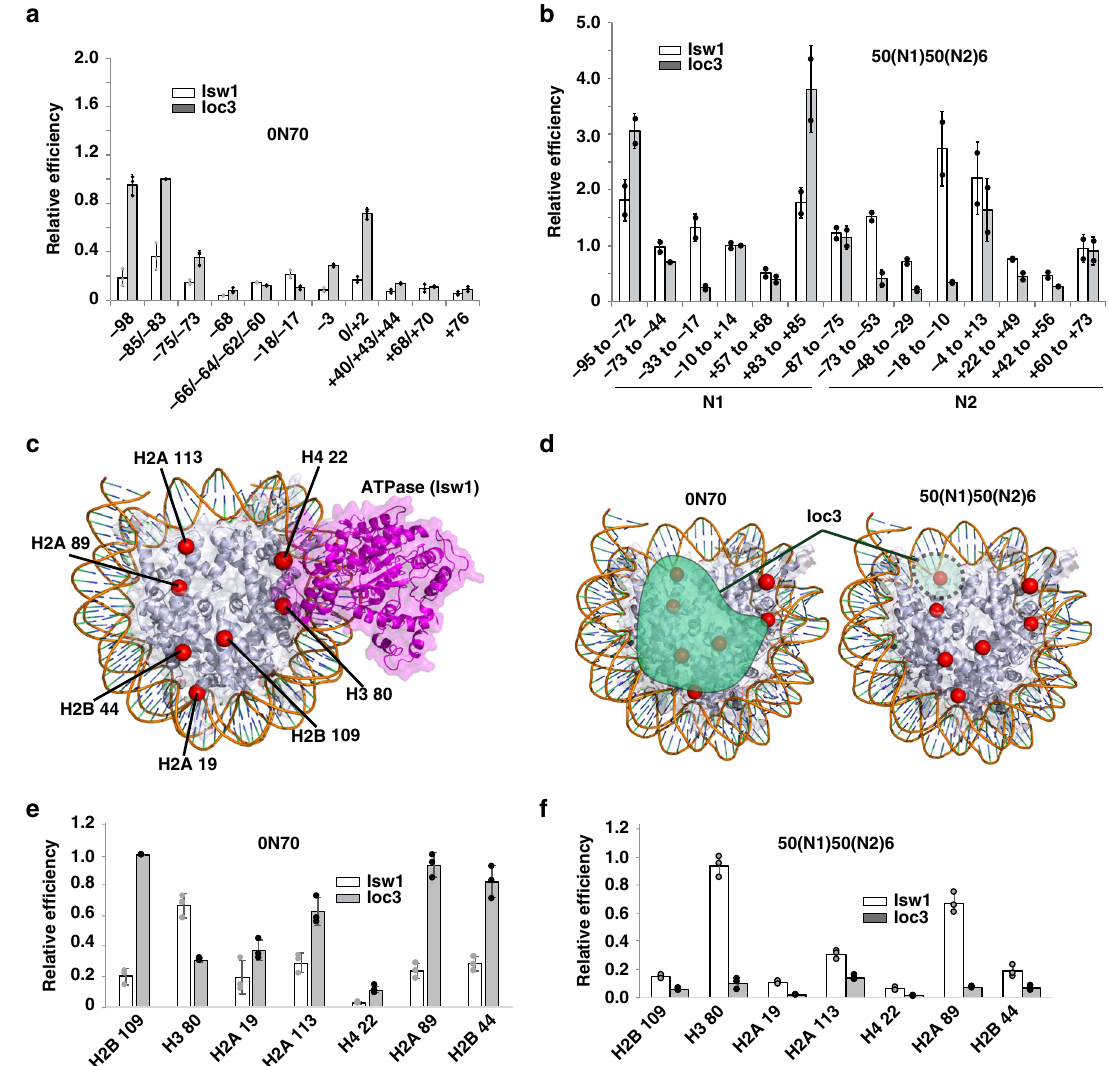
Fig. 4 Allosteric changes in Isw1 and Ioc3 interactions with dinucleosomes revealed by site-directed DNA and histone crosslinking. a , b The nucleosomal and extranucleosomal DNA binding sites of Isw1 and Ioc3 were mapped by DNA crosslinking with ( a ) 0N70 mononucleosomes and ( b ) 50 (N1)50(N2)6 dinucleosomes. Numbering refers to the number of nucleotides from the dyad axis (0) where photoreactive residues were incorporated. Open bars are for Isw1 and closed bars for Ioc3. c Site-directed histone crosslinking at total of 7 sites (red spheres) was used to map the interactions of Isw1 and Ioc3 with the lateral surface(s) of mono- and di-nucleosomes. The location of the Isw1 ATPase domain shown in magenta is from a recent cryo- EM study (PDB 6IRO 20 ). d Summary of where Ioc3 binds nucleosomes when ISW1a is bound to either 0N70 mononucleosomes or 50(N1)50(N2)6 dinucleosome is shown (highlighted in teal). The different sites being probed inside of nucleosomes are depicted as in ( c ). e , f The extent of Ioc3 and Isw1 crosslinked to the indicated modi fi ed histone residue is shown for ( e ) 0N70 and ( f ) 50(N1)50(N2)6 dinucleosome. The open and closed bars are respectively Isw1 and Ioc3. Nucleosomes were fully bound and had 20 nM of mono- or dinucleosomes with respectively 25 or 40 nM ISW1a for mono- and dinucleosome reactions. DNA (orange) and histones (gray) are depicted. All histone crosslinking experiments were from n = 3 independent experiments and error bars are presented as mean values + / − SD. Source data are provided as a Source Data fi